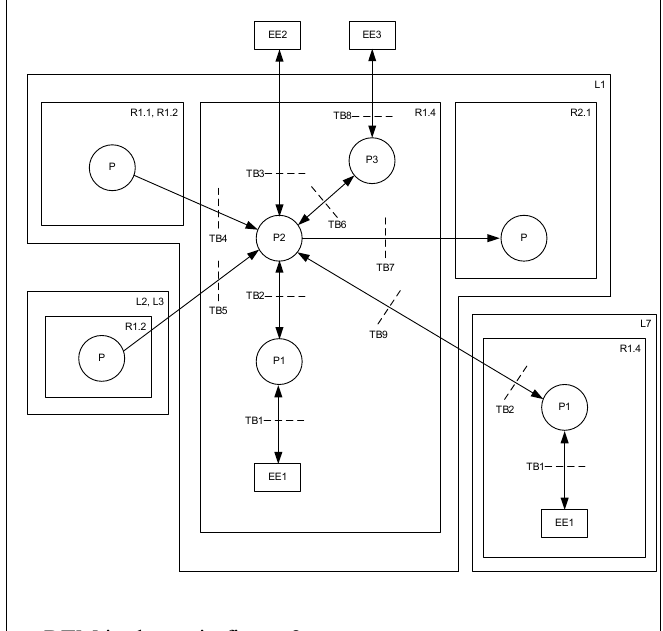
Figure 2. An example of a IPS model of a real OA operating in RTM